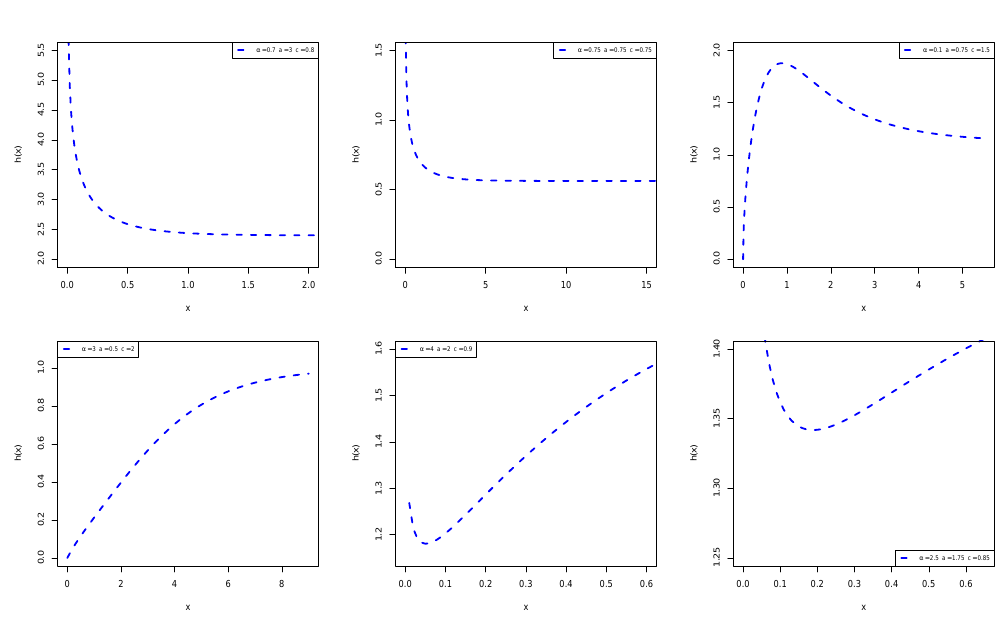
Figure 2. Plots of APExE HRF for different parametric